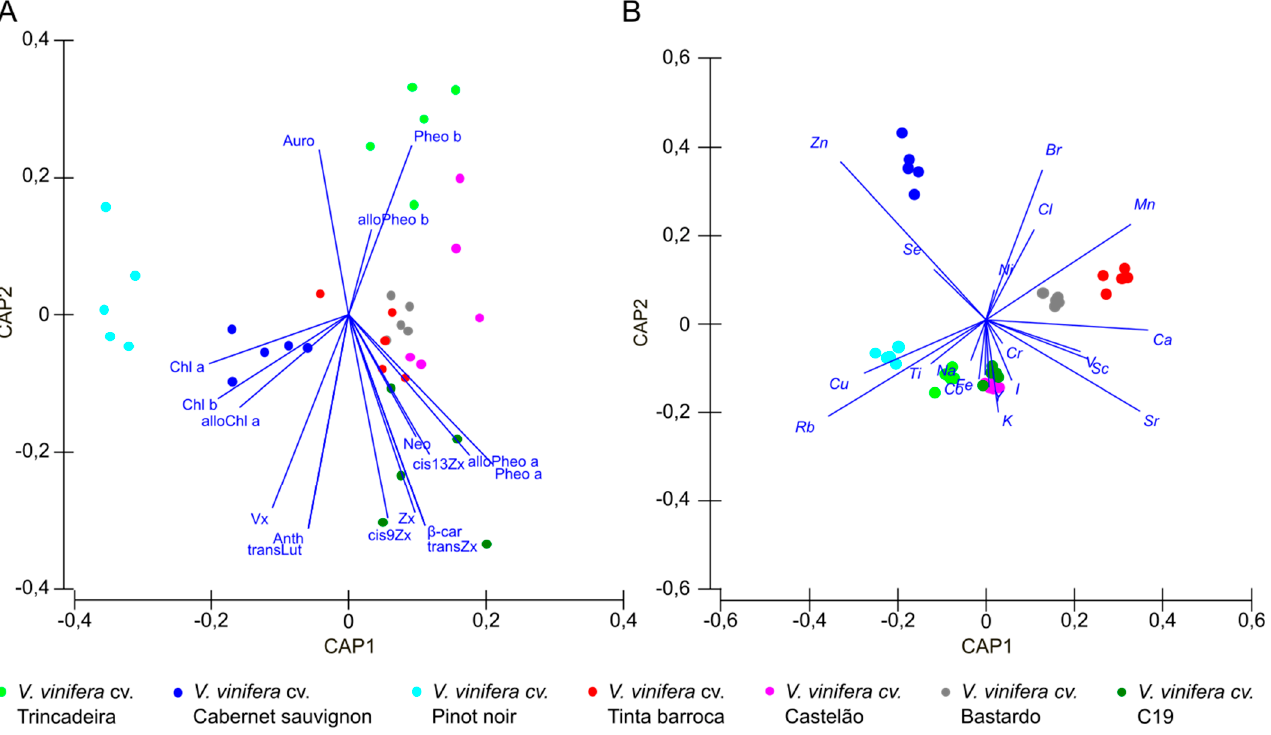
Figure 1. Canonical analysis of principal coordinates (CAP) plots between Vitis genotypes considering ( A ) pigments concentration and ( B ) the elements leaf concentration.